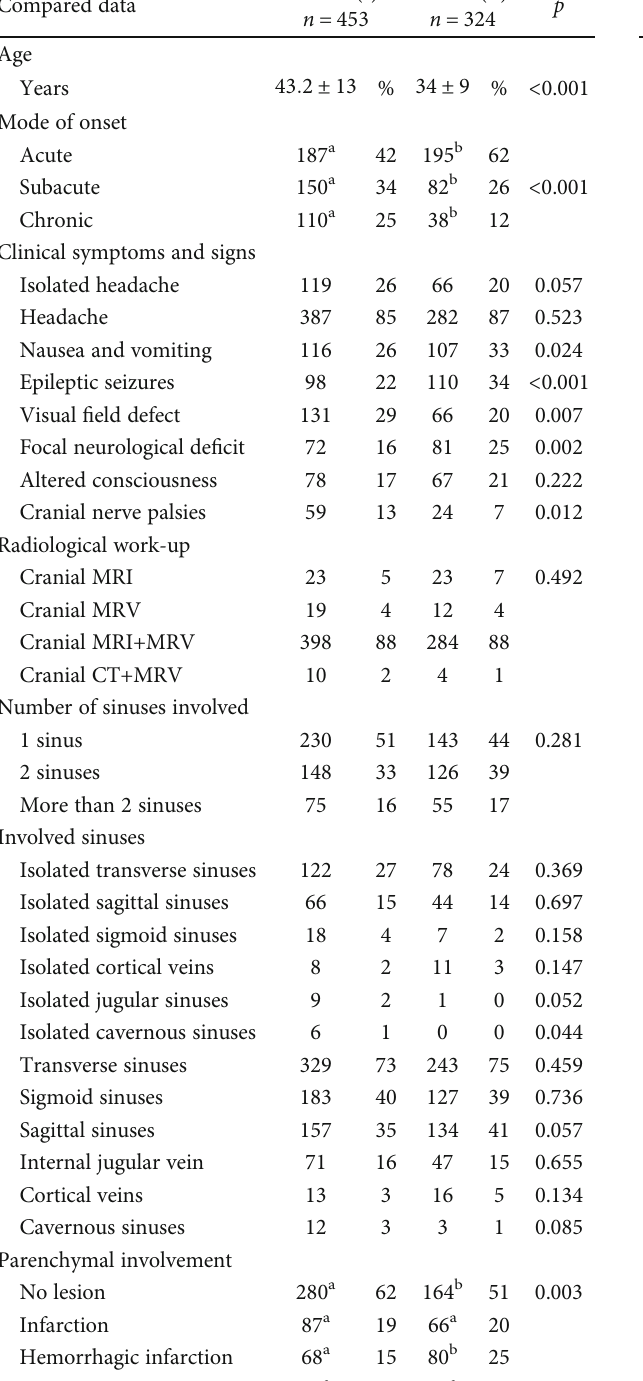
Table 1: Compared data of demographic and clinical aspects of groups.